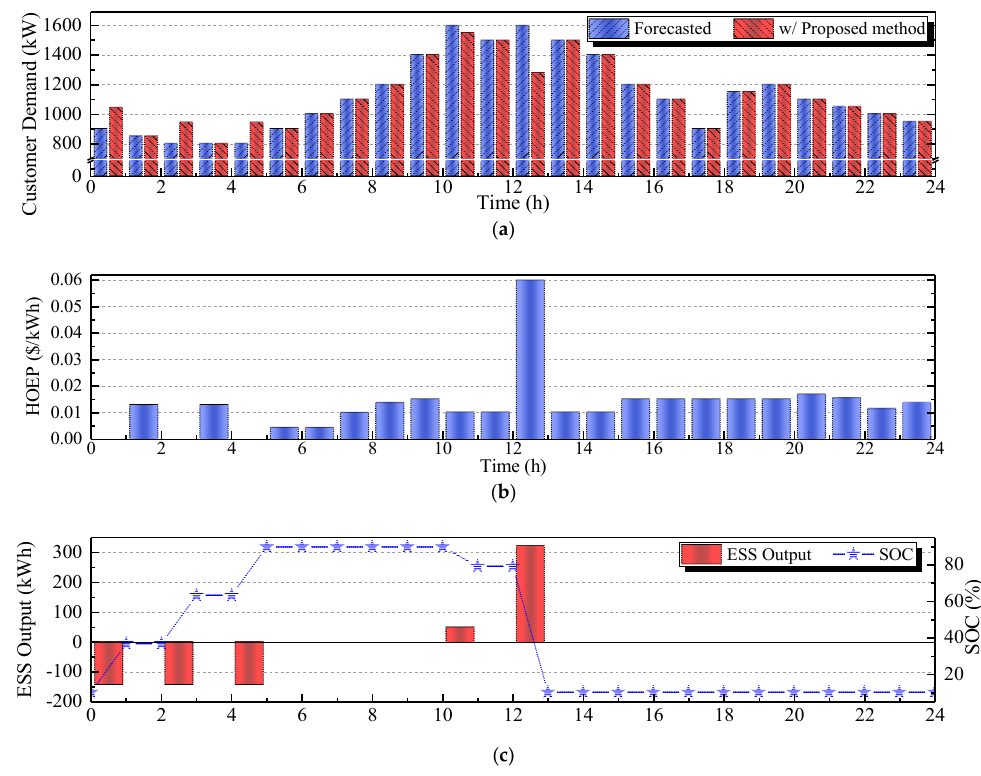
Figure A6. Results of Case 5: ( a ) Customer demand; ( b ) Forecasted HOEP; ( c ) Scheduled output and SOC of the ESS.